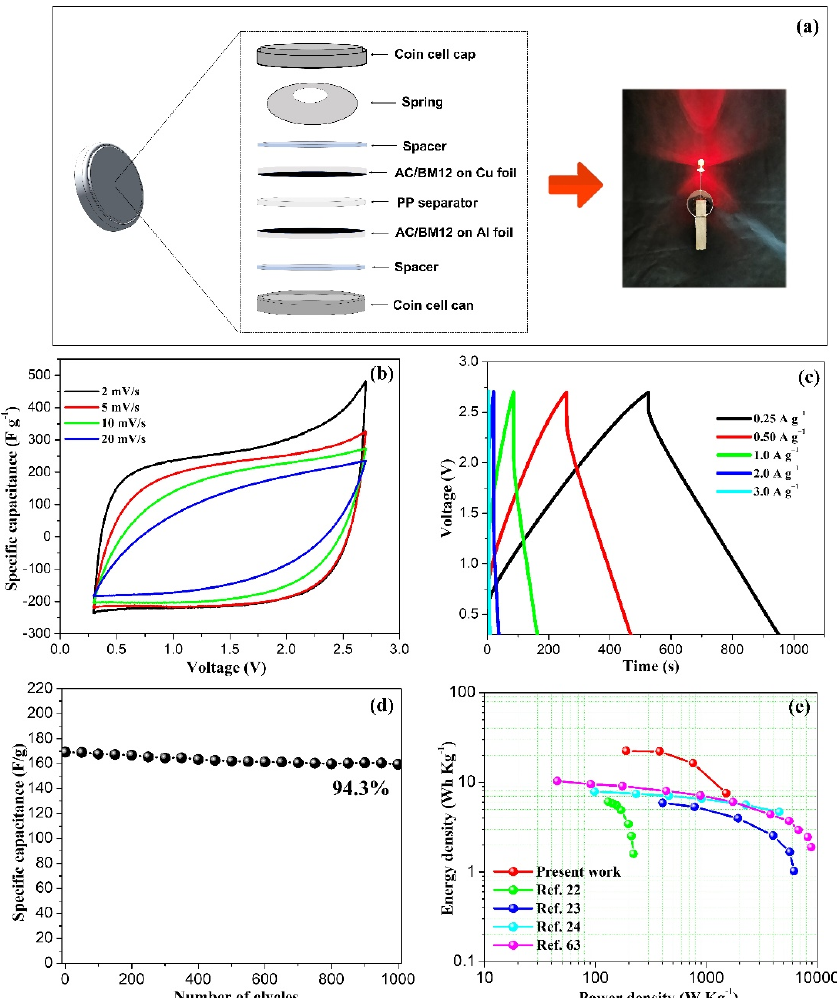
Figure 9. ( a ) a Schematic diagram of a fabricated coin cell powering an LED, ( b ) CV curves, ( c ) GCD curves, ( d ) the cycling retention at 1 A g − 1 and ( e ) Ragone plot of energy density and power density of AC/BM12 in 1 M LiPF 6 compared with various porous carbons from sugarcane bagasse in other reported data [22–24,63].